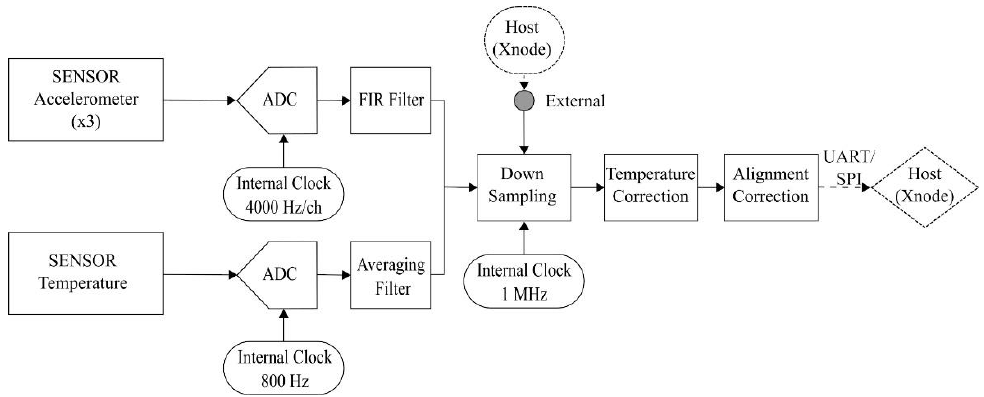
Figure 3. Functional block diagram for Epson M-A352 [37].